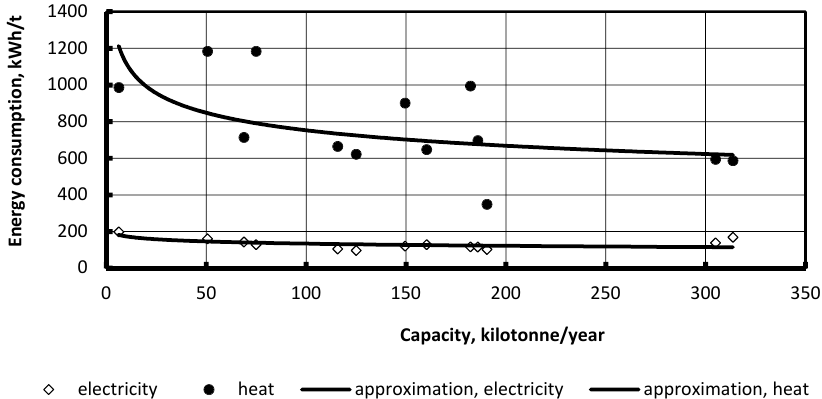
Figure 3. Specific energy consumption (kWh per ton of sunflower oil) vs. annual sunflower oil capacity (thousand tons of seed) [23].